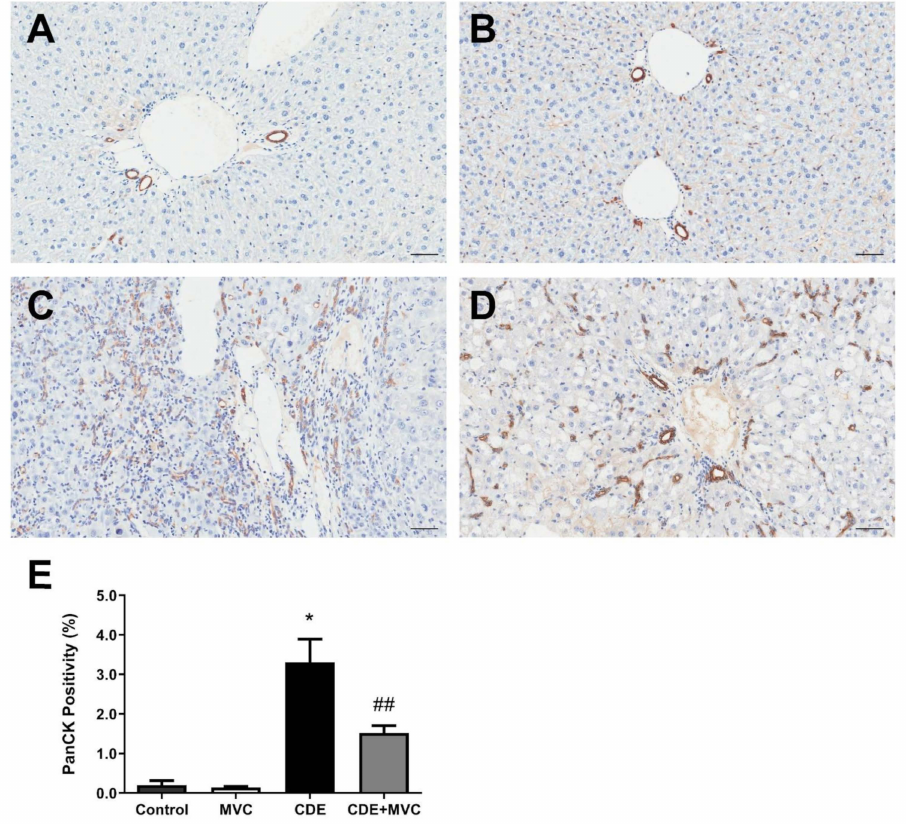
Figure 1. PanCK-positive cell numbers are reduced by MVC in CDE liver. ( A – D ) Representative images of histological sections stained with PanCK antibody, from 16-wk control ( A ), MVC ( B ), CDE ( C ) and CDE+MVC ( D ) animal groups. ( E ) Quantitation of PanCK staining by pixel positivity. Bars represent means + SEM for n = 4, 8, 4 and 8 in the control, MVC, CDE and CDE+MVC groups, respectively. * p < 0.05 compared to control. ## p < 0.01 compared to CDE group. Scale bars represent 50 µ